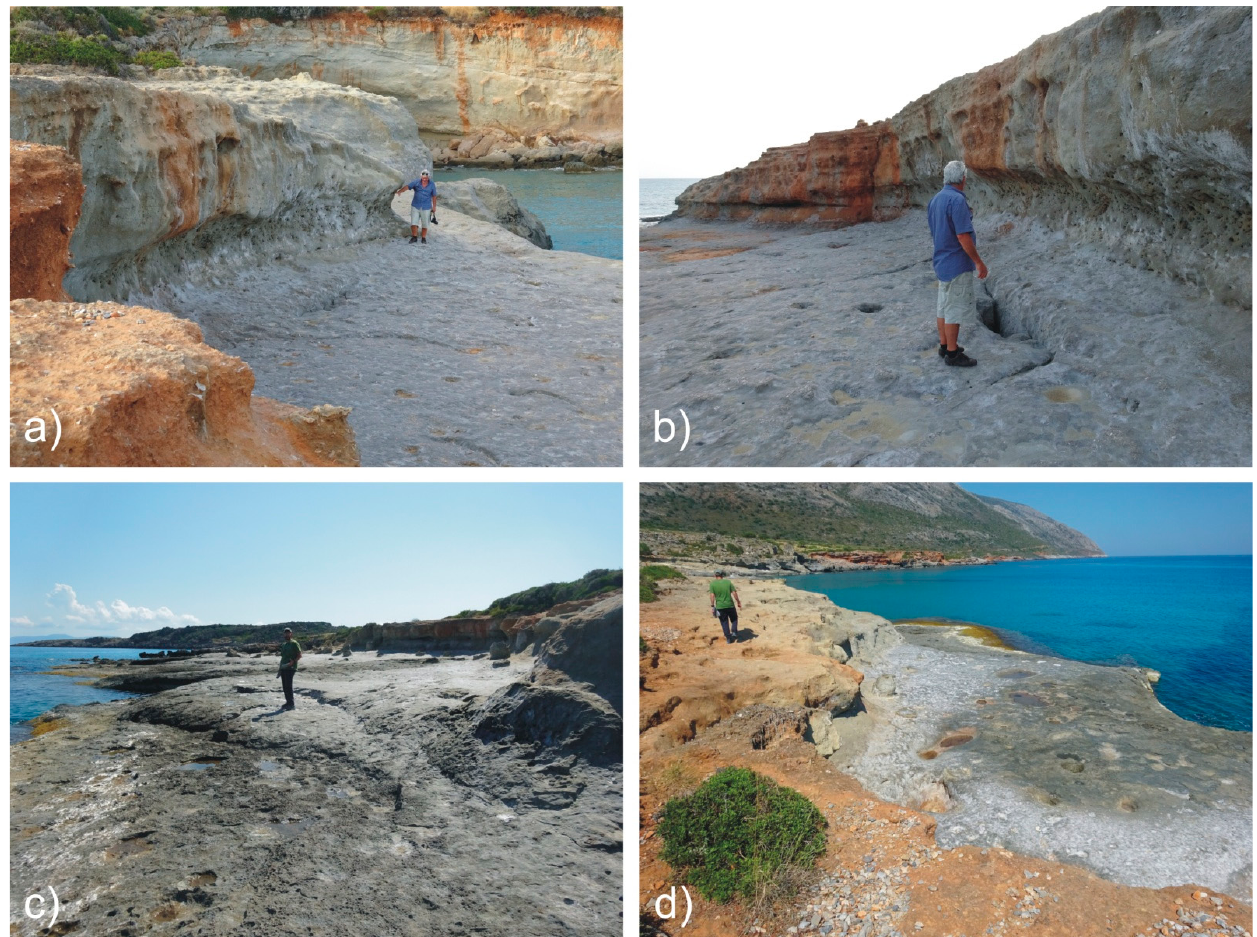
Figure 8. ( a,b ) Uplifted abrasion platforms between Profitis Ilias and Agia Marina, backed by a low, steep cliff with a tidal notch at its base. ( c,d ) Uplifted abrasion platforms at Agia